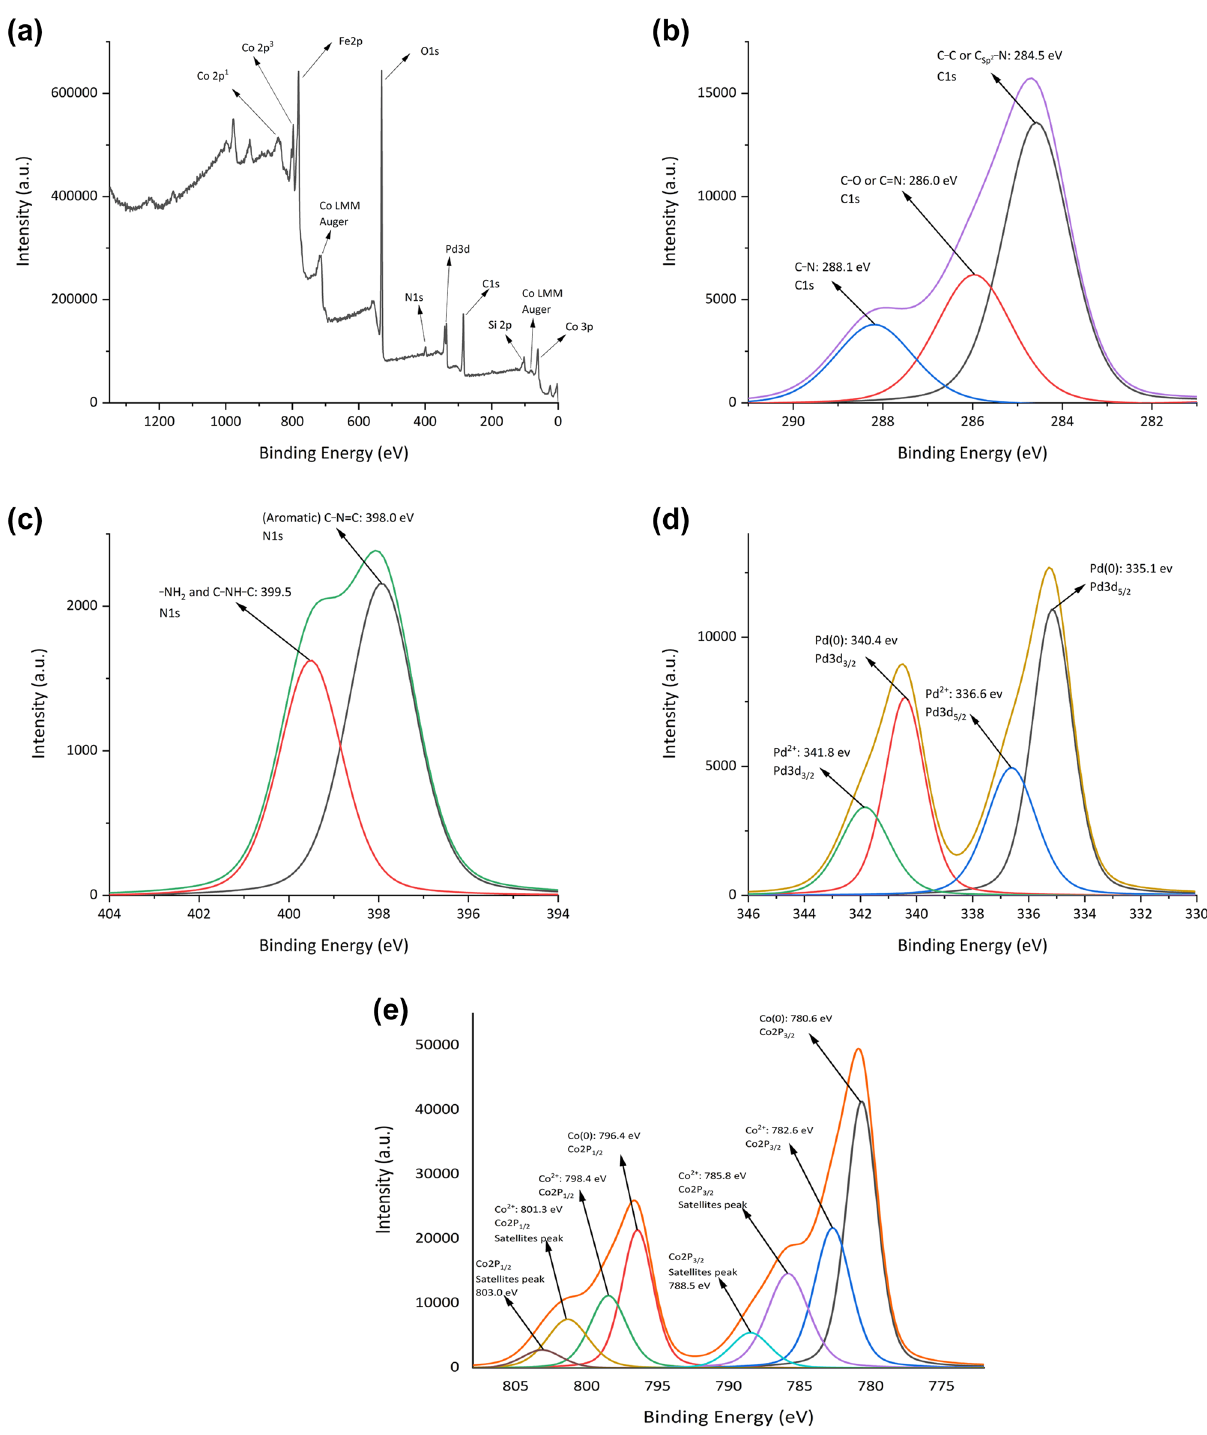
Figure 5. ( a ) XPS analysis of γ-Fe 2 O 3 @MBD/Pd-Co, ( b ) C 1s, ( c ) N 1s, ( d ) Pd 3d and ( e ) Co